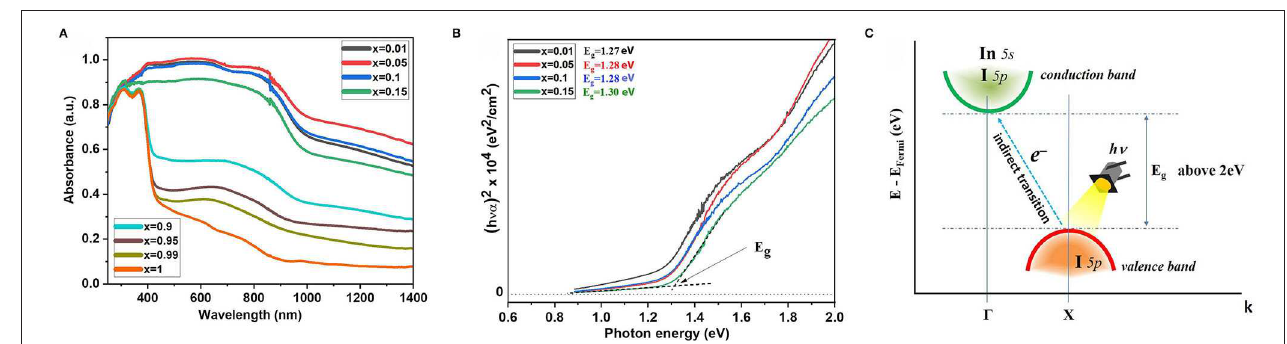
Frontiers in Chemistry |